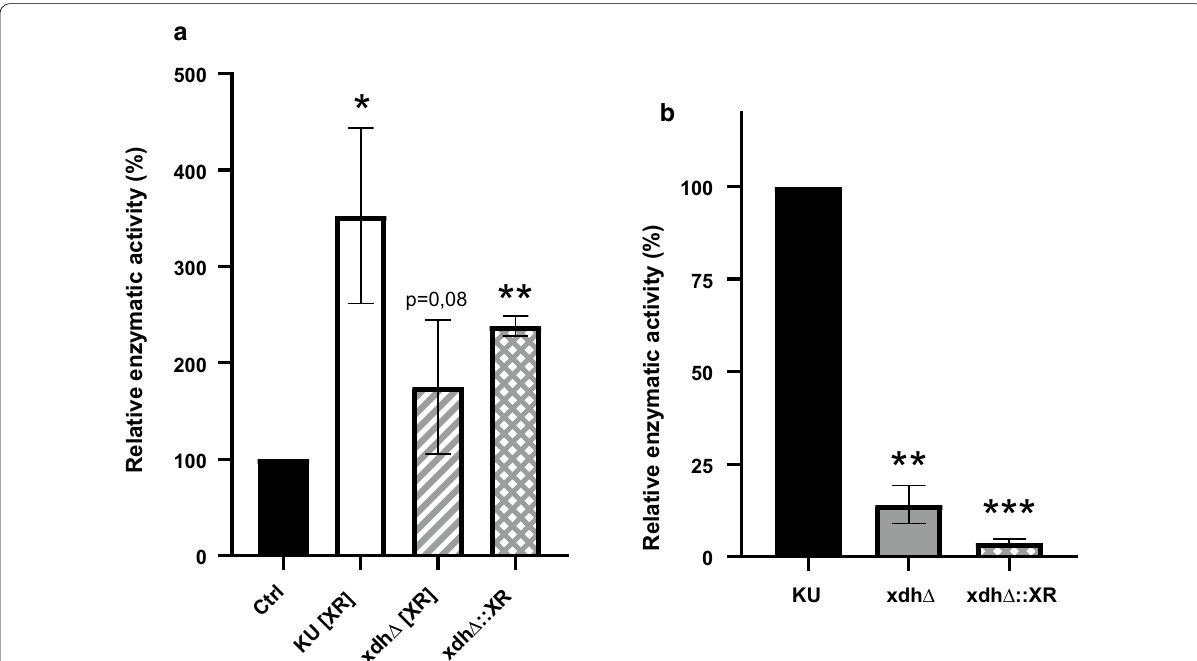
Fig. 3 Enzymatic activity analysis of M. guilliermondii cell lysates. Measurement of co-factor conversion rates is displayed as a relative enzymatic XR-activity of lysates of KU [EV] (Ctrl), KU [XR], xdhΔ [XR] and xdh∆::XR; b relative enzymatic XDH-activity of lysates of KU, xdhΔ and xdh∆::XR; Displayed are mean values SD of at least 3 replicate experiments, each performed in triplicates. The control and parental strains were set to 100%. ± Asterisks indicate p-values (* p < 0.05; ** p < 0.005 and *** p = = =